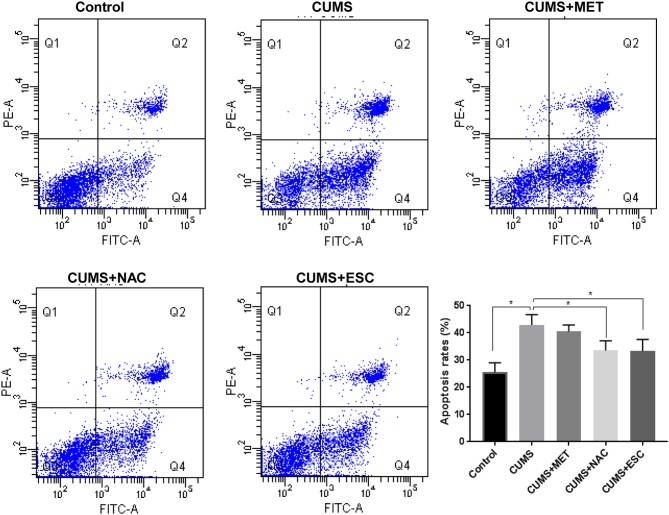
Effect of MET, NAC, and ESC on the apoptosis rates of hippocampus cells after stress. *P < 0.05 (one way ANOVA), n = 9.